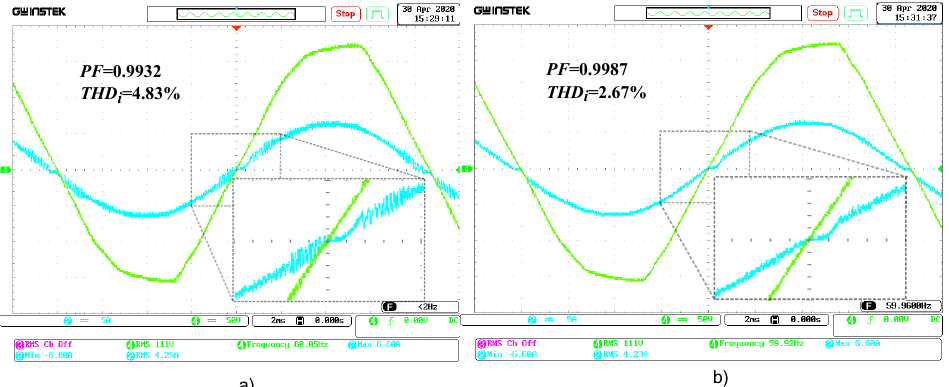
Figure 22. Zero crossing of AC current: ( a ) PI-SMC control; and ( b ) SMC